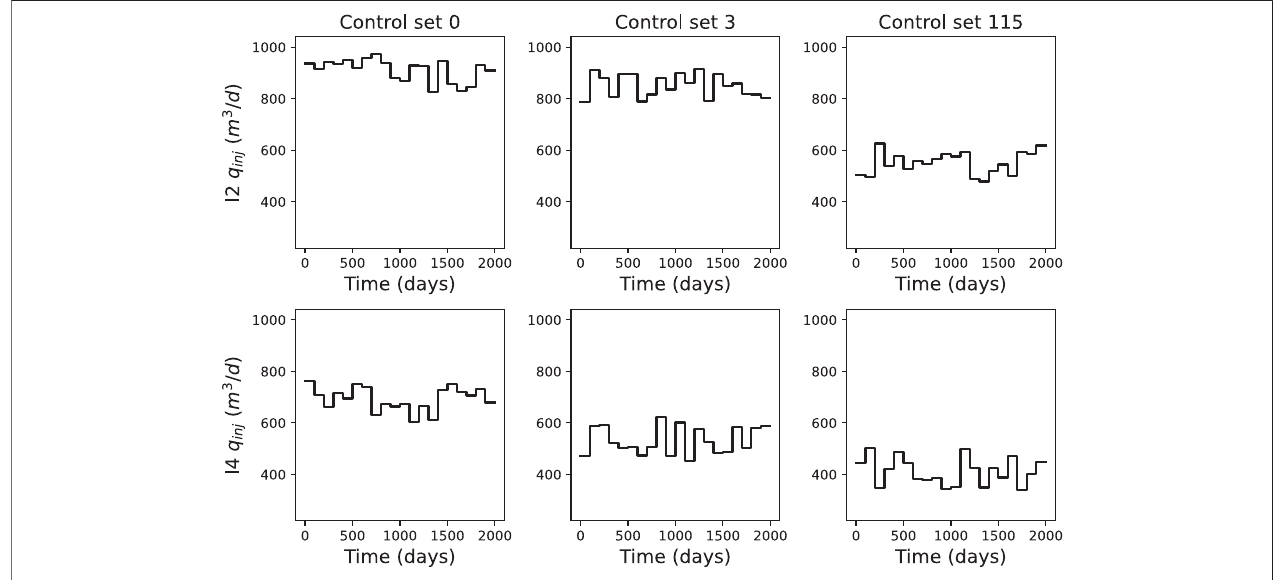
FIGURE 12 | Injection water fl owrate controls examples for wells I2 ( fi rst row) and I4 (second row) where each column represents a control set.